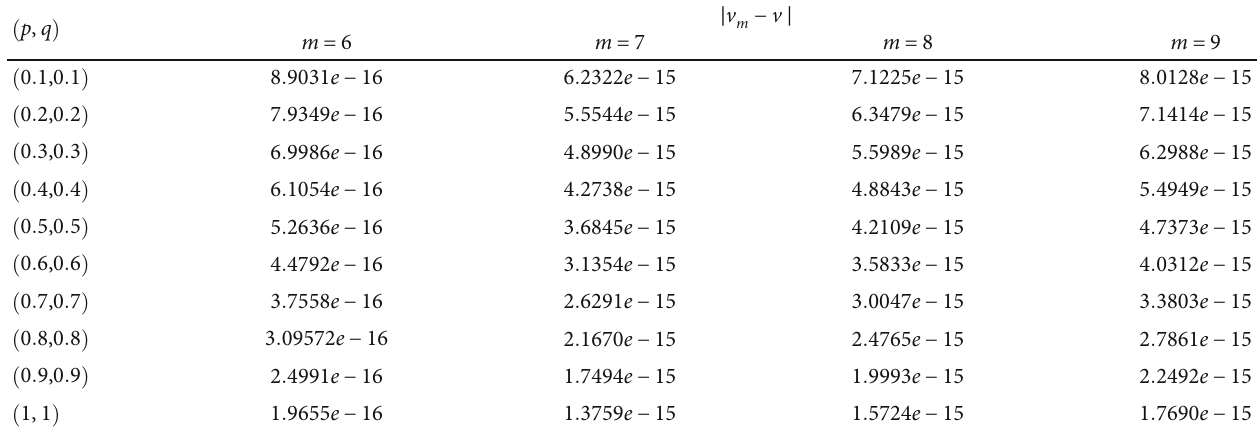
Table 2: The absolute error for di ff erent values m for Example 7 at various points ð p , q Þ .